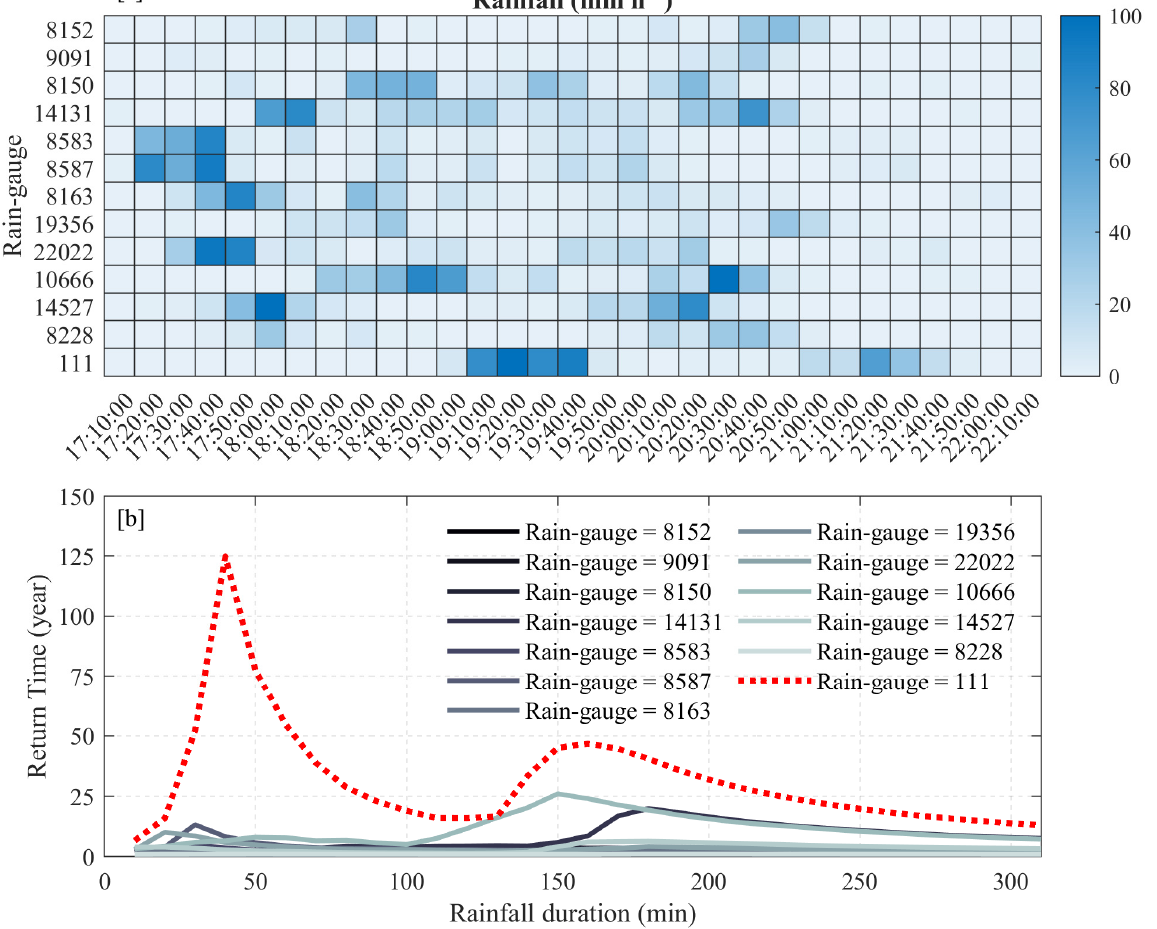
Figure 4. ( a ) Temporal distribution of rainfall intensity, and ( b ) severity graph obtained from each rain gauge located in the study area.